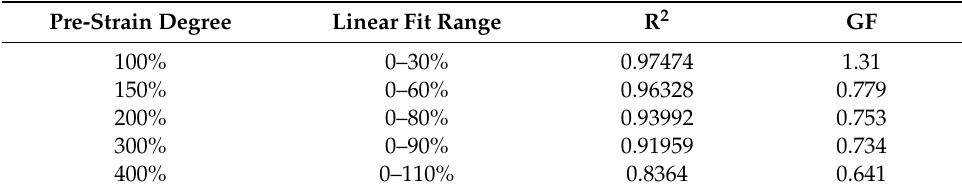
Table 1. Comparison of various strain sensors with di ff erent